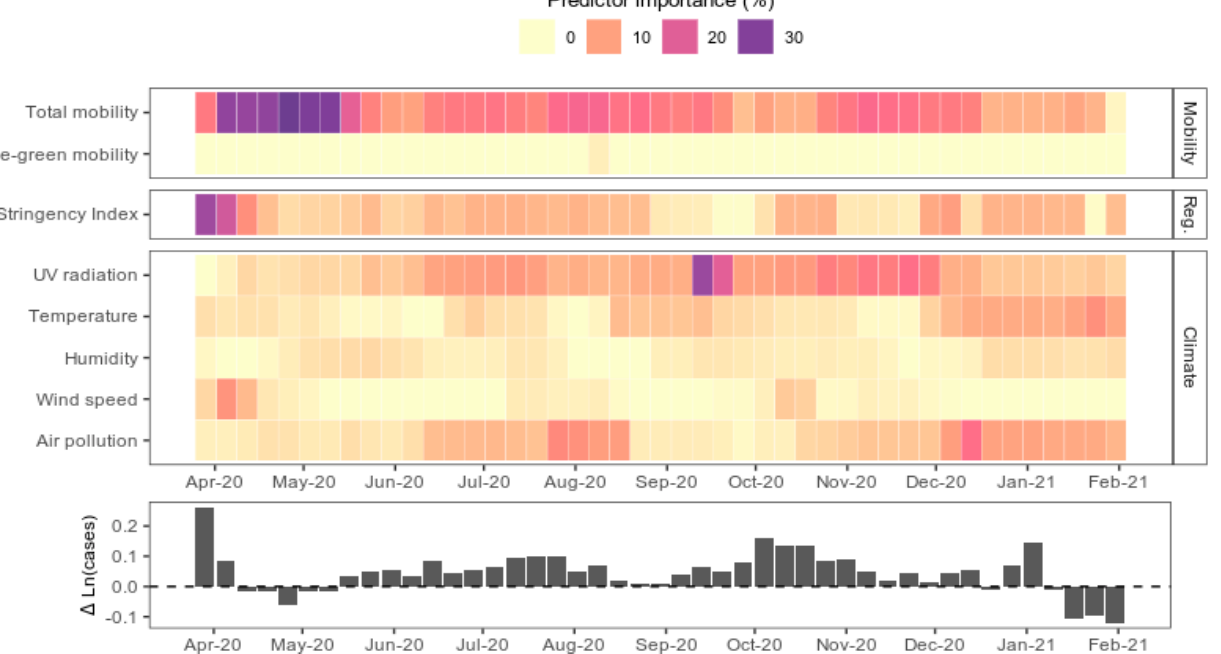
Figure 1. Relative importance of predictor variables in machine learning model forecasts of COVID-19 growth rates. The colour saturation of weekly blocks reflects the relative importance of predictor variables in forecast models trained on the preceding two months of data. Importance is defined as the decrease in model prediction accuracy when the variable in question is omitted from the model. An elastic net model was fitted to select the best predictors for a given time window. The selected variables were then used to build a random forest model, to assess the relative importance of each variable while accounting for non-linear effects. The response variable, COVID-19 growth rate aggregated at the global level, is plotted in the lower panel for reference.